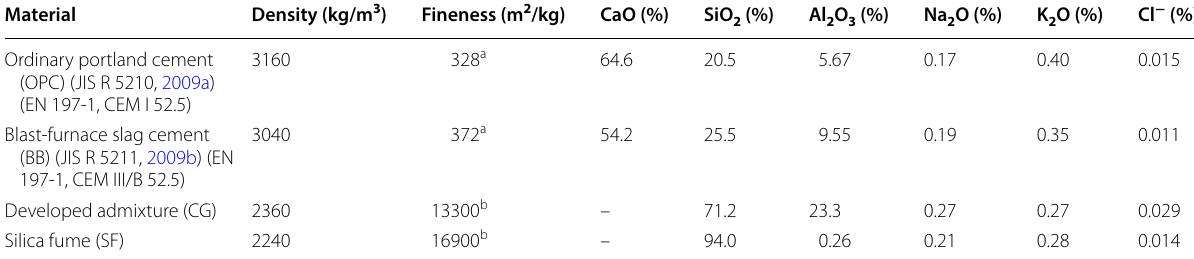
Table 1 Properties of cementitious materials.